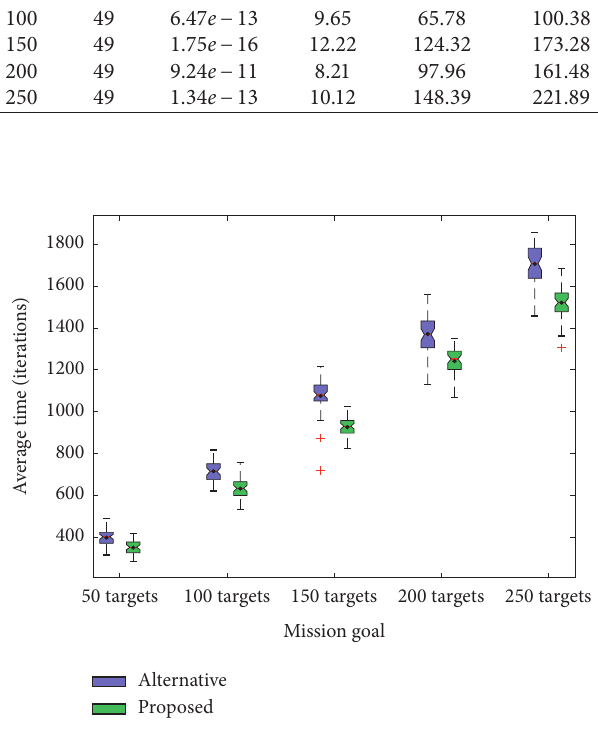
Figure 8: Investigating the effectiveness of the proposed algorithm against an alternative approach. Each of the five boxplots shows that the proposed algorithm outperforms the alternative method. The means are marked on each of the boxes with a black dot.